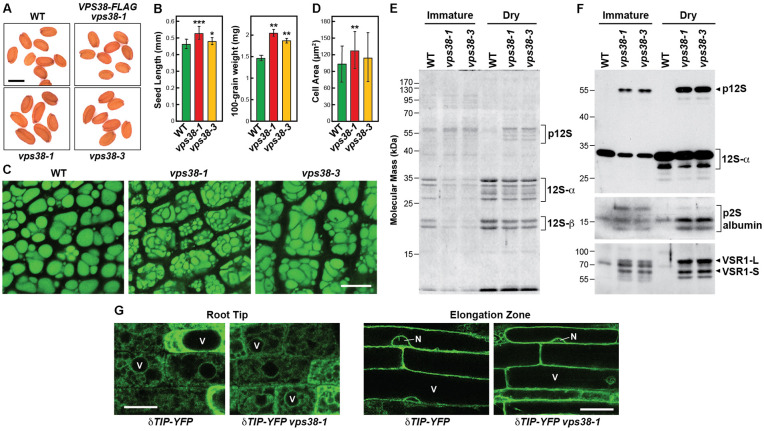
vps38 mutants produce larger seeds and display defects in storage protein processing and vacuolar sorting receptor (VSR) accumulation. (A,B)
vps38 mutants produce larger seeds. (A) Images of seeds from WT, vps38-1, vps38-3, and VPS38-FLAG complementation plants. Scale bar = 0.5 mm. (B) Quantification of seed length and weight. Each bar represents the mean (±SD) of 60–100 seeds. Asterisks indicate significant differences from WT by Student’s t-test; ∗, ∗∗, and ∗∗∗ represent p-values of <0.05, <0.01, and <0.001, respectively. (C,D) Cotyledons of vps38 mutants accumulate larger cells with irregularly shaped protein storage vacuoles (PSVs). (C) PSVs were visualized in cotyledons dissected from dry seeds by autofluorescence as detected using confocal fluorescence microscopy. Scale bar = 10 μm. (D) Quantification of cotyledon cell size. Each bar represents the mean (±SD) of 39–46 cells. ∗∗ indicates a significant difference from WT by Student’s t-test (p-value < 0.01). (E,F) Abnormal accumulation of 12S globulin and 2S albumin precursors, and VSR1 in vps38 mutants. Total proteins from immature and dry seeds from WT and vps38 mutants were either (E) stained for protein with Coomassie Blue, or (F) subjected to immunoblot analysis with anti-12S globulin, anti-2S albumin, and anti-VSR1 antibodies. Brackets/arrowhead locate the p12S precursor of the 12S-α and 12S-β globulins, and the precursor to the 2S albumins. The 80-kDa VSR1-L and 60-kDa VSR1-S versions of VSR1 are indicated by the arrowheads (Shimada et al., 2003a). (G) Vacuolar morphology in WT and the vps38-1 roots expressing the tonoplast marker δTIP-YFP. Shown are images of cells either near the root tip or in the elongation zone. Scale bar = 10 μm.